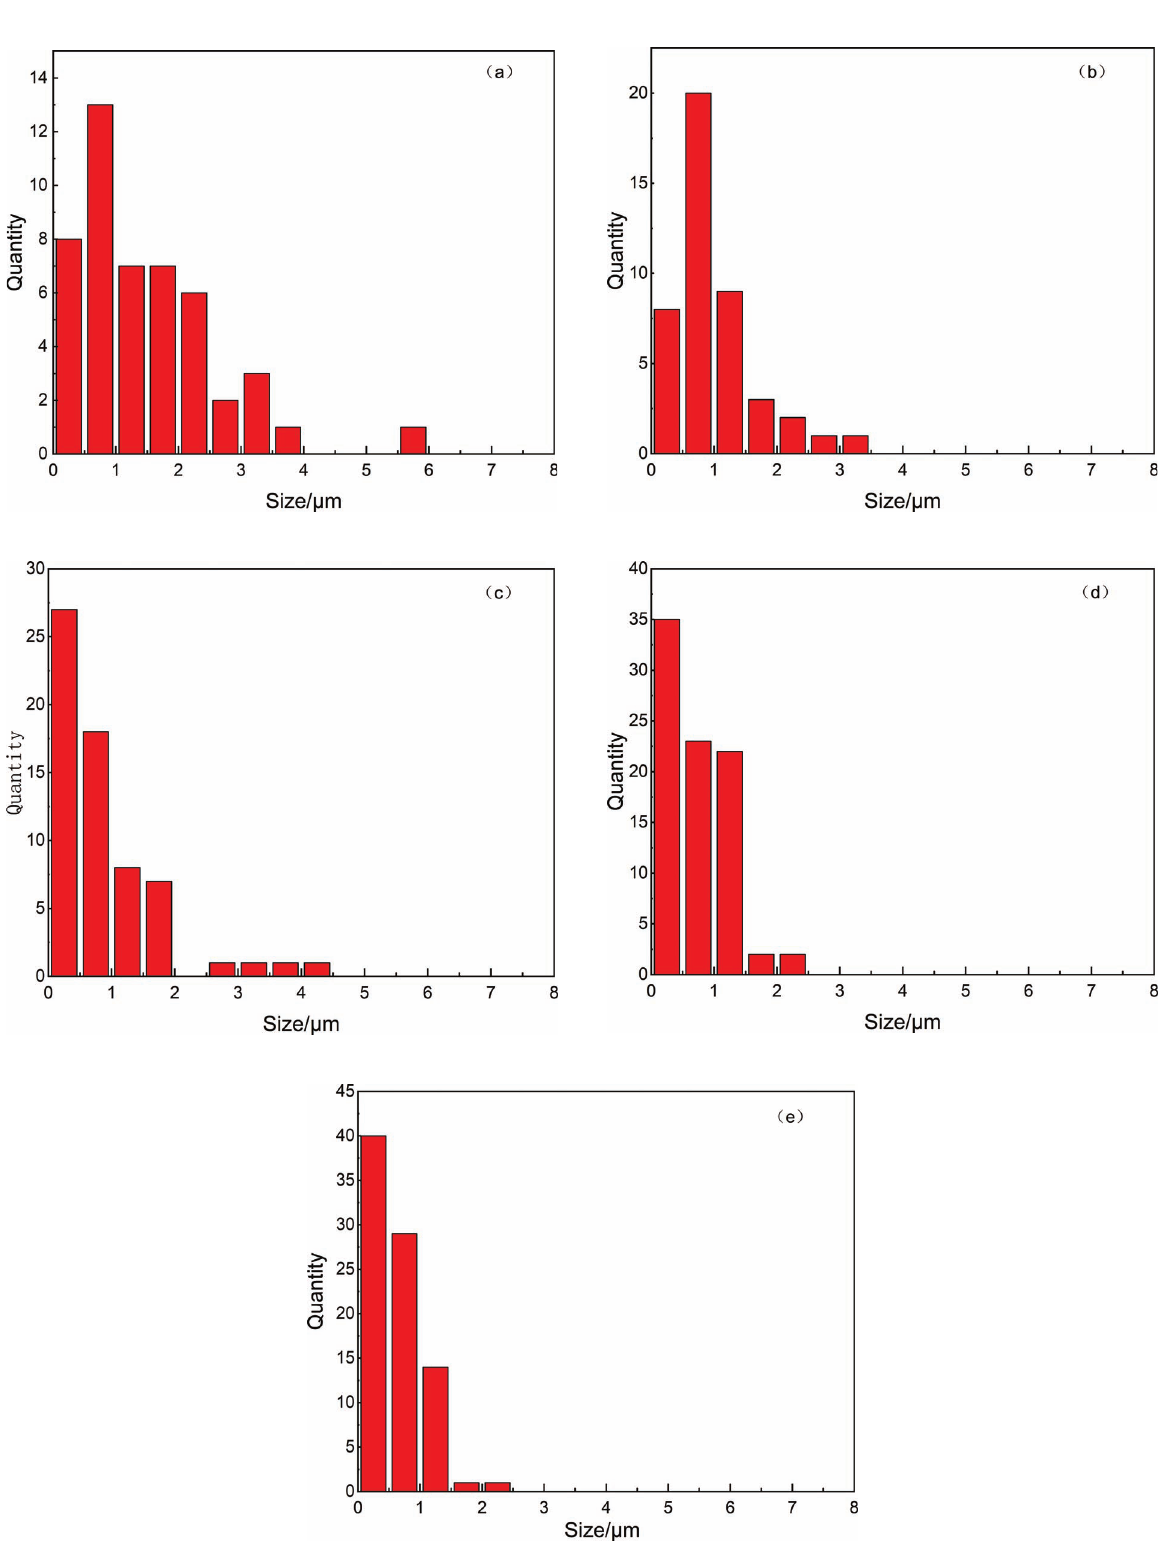
Figure 10: Particle size distribution of the fractured surface morphology (immersion in liquid nitrogen) of PLA/PBAT blends with different content of ETBP: (a) neat, (b) 0.5 phr, (c) 1.0 phr, (d) 3.0 phr and (e) 5.0